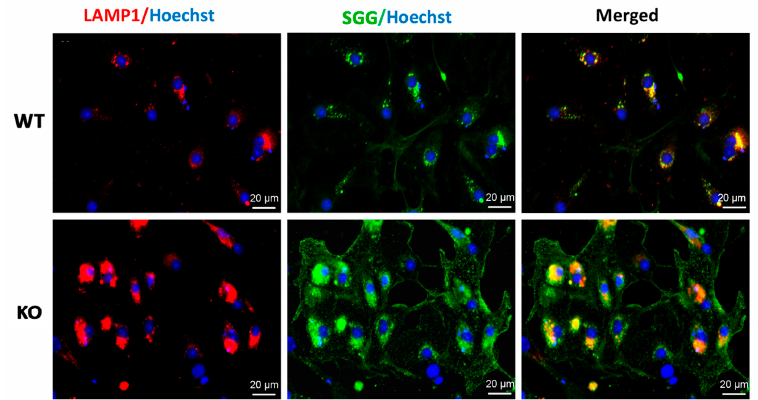
Figure 2. Immunolocalization of SGG and LAMP1 in Sertoli cells from 8-month-old WT mice ( top panel ) and in Sertoli cells from age-matched Arsa − / − mice ( bottom panel ). Left and middle panels show LAMP1 and SGG localization, respectively, whereas the right panels display the merged signals of SGG with LAMP1. Results shown are representative from three replicate